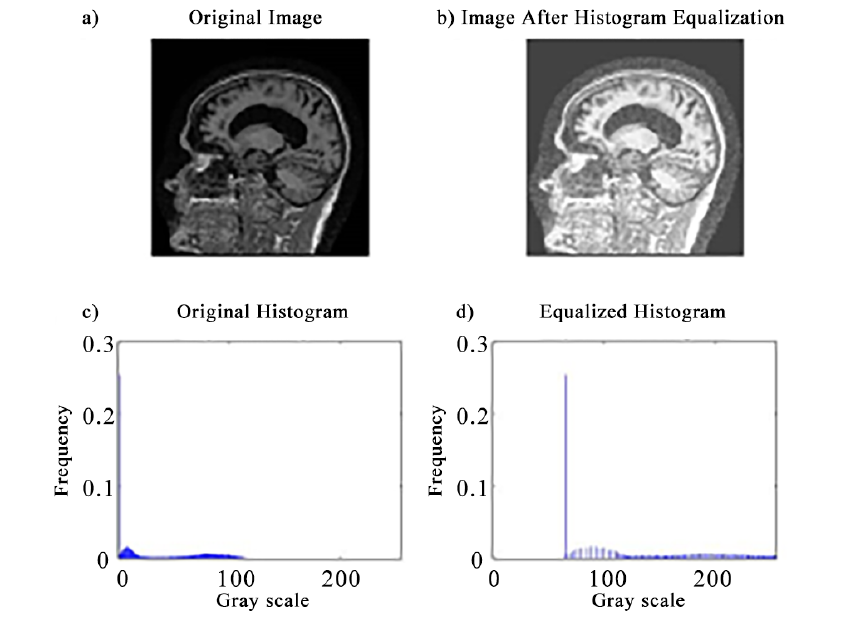
Figure 7. ( a ) Original image. ( b ) Histogram equalization image. ( c ) Original image histogram. ( d ) Histogram after equalization. In the histogram, the abscissa represents the gray scale and the ordinate represents the